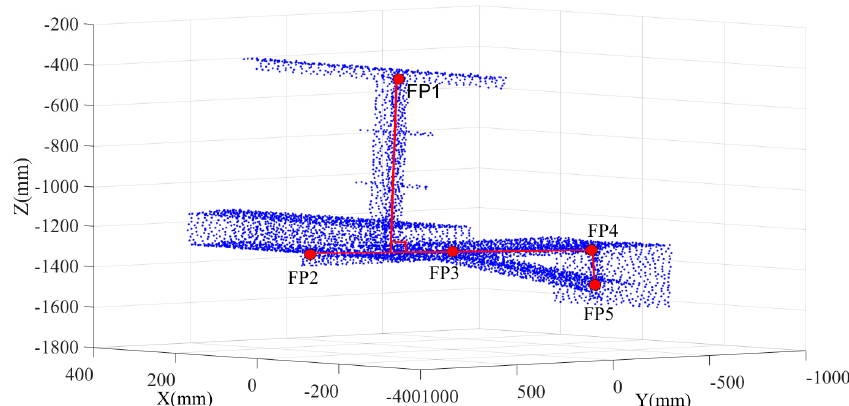
Appl. Sci. 2019 , 9 , x FOR PEER REVIEW Figure 19. Schematic diagram of the processed 3D point cloud. Figure 19. Schematic diagram of the processed 3D point cloud.